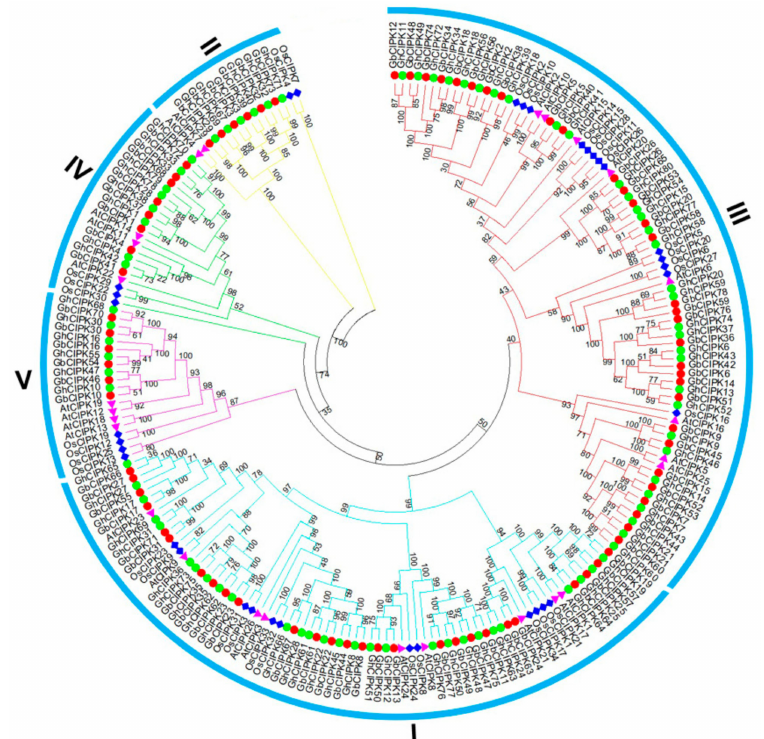
Figure 1. Phylogenetic relationships of calcineurin B-like protein-interacting protein kinases (CIPKs) from G. hirsutum , G. barbadense , Arabidopsis , and rice. The unrooted phylogenetic tree was constructed with MEGA 5.0 using the neighbor-joining method, and bootstrap analysis was performed with 1000 replicates. The CIPKs from G. hirsutum , G. barbadense, Arabidopsis , and rice are marked with green dots, red dots, magenta triangles, and blue rhombus,